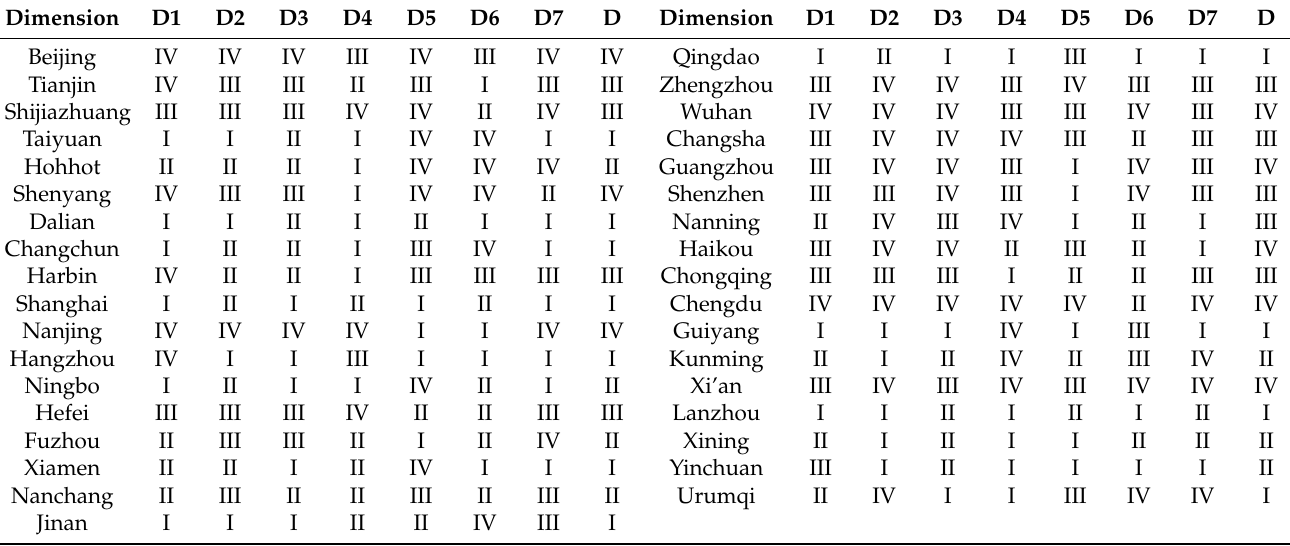
Table 7. The UPSCC performance quadrant for the sample